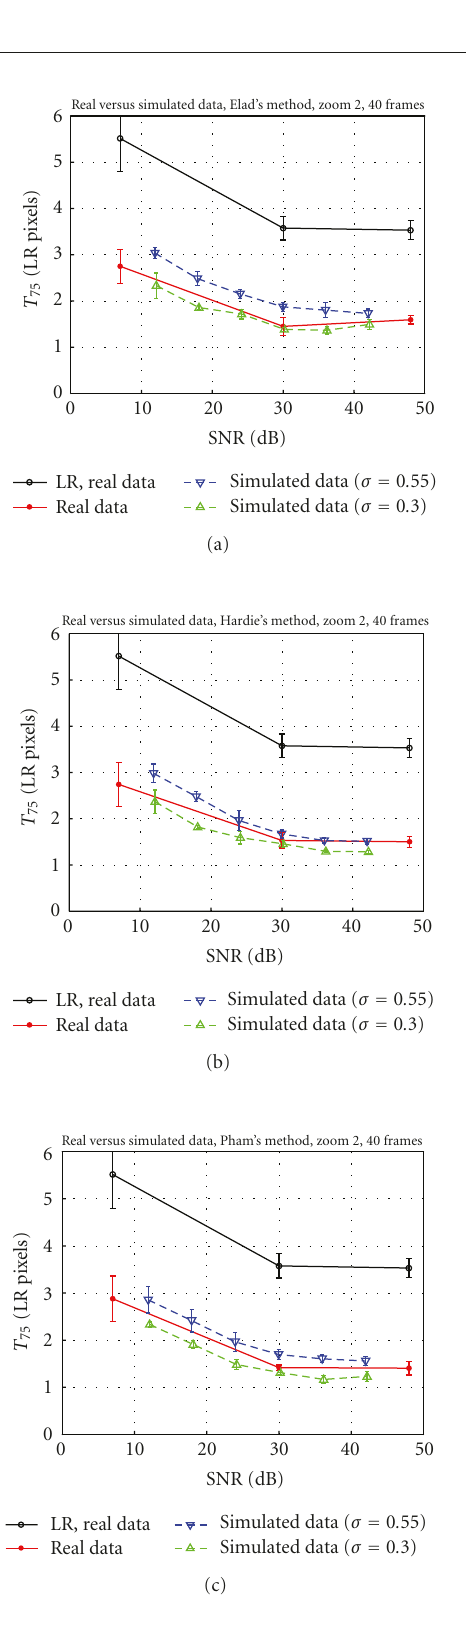
Figure 8: Performance measurements on real-world and simulated data (40 frames). Blue line: simulated data created with σ PSF = 0 . 55 and ff = 80%, green line: simulated data created with σ PSF = 0 . 3 and ff = 80%. (a) Elad, (b) Hardie ( σ = 0 . 55, λ = 0 . 01), (c) Pham ( σ = 1, λ = 10 − 3 , β = 10). All data is processed with zoom factor 2.